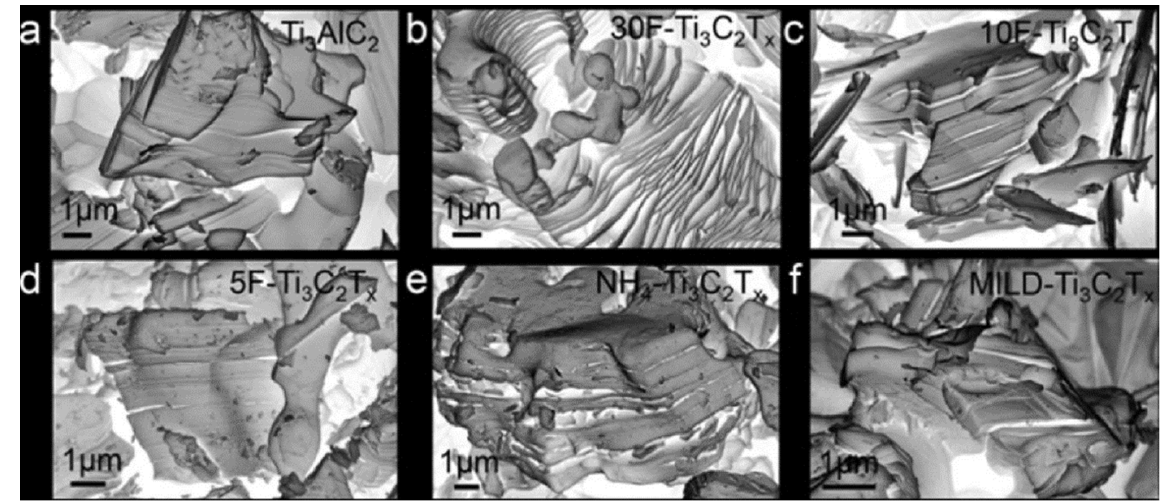
Figure 3. SEM micrographs show ( a ) Ti 3 AlC 2 (MAX) powder and MAX powder etched with ( b ) 30 wt.% HF; ( c ) 10 wt.% HF and ( d ) 5 wt.% HF; ( e ) ammonium hydrogen fluoride; and ( f ) mild LiF/HCl. Modified from [29], with permission from American Chemical Society, 2017.